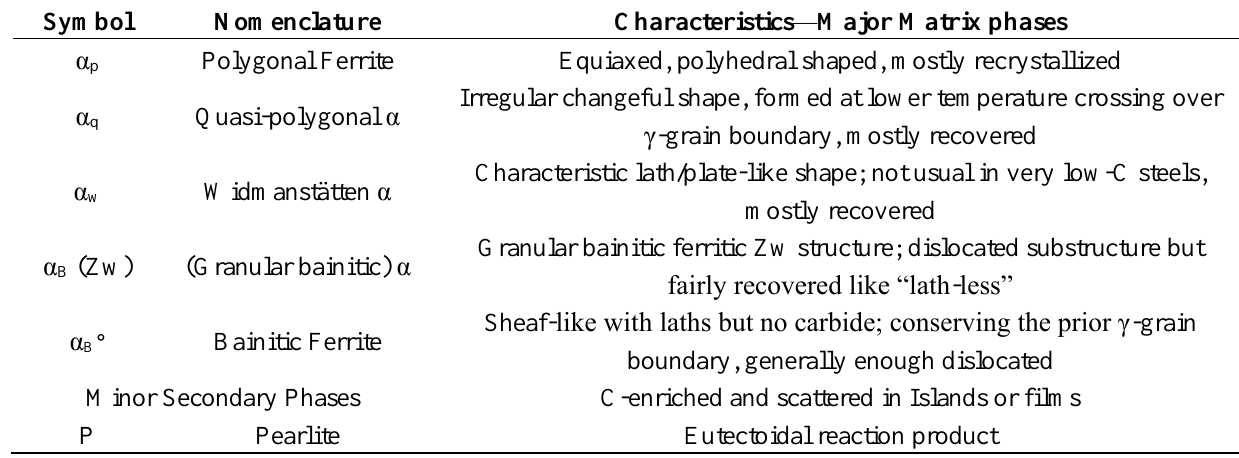
Table 2. ISIJ Transformation Products Nomenclature and Classification